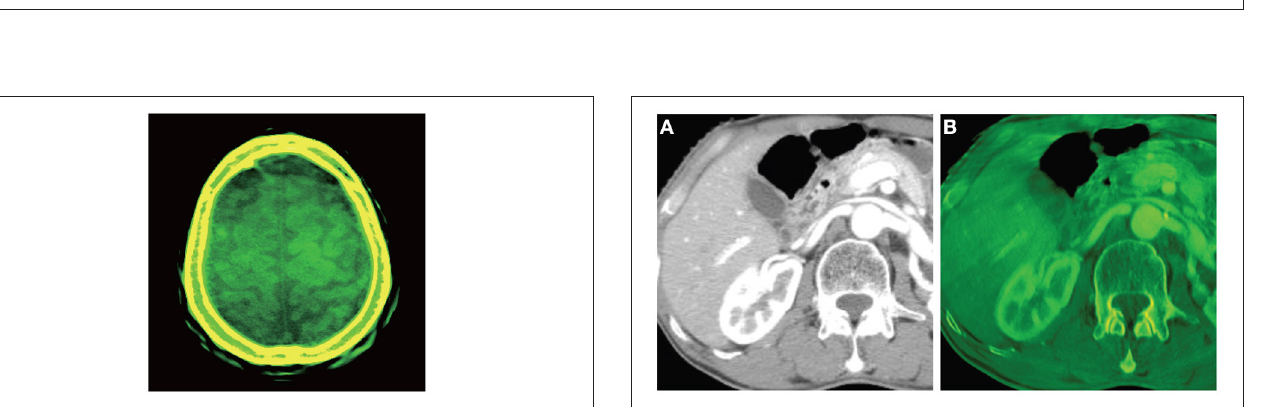
FIGURE 2 | Brain images reconstructed by a Shinva XHCT-16 and the proposed method at monochromatic 70 keV from the same data. From left, (A) Shinva XHCT-16 with the display window [ − 150, 210] (Unit: HU); (B) reconstructed photoelectric component; (C) reconstructed Compton scatter component; (D) reconstructed attenuation coefficients.